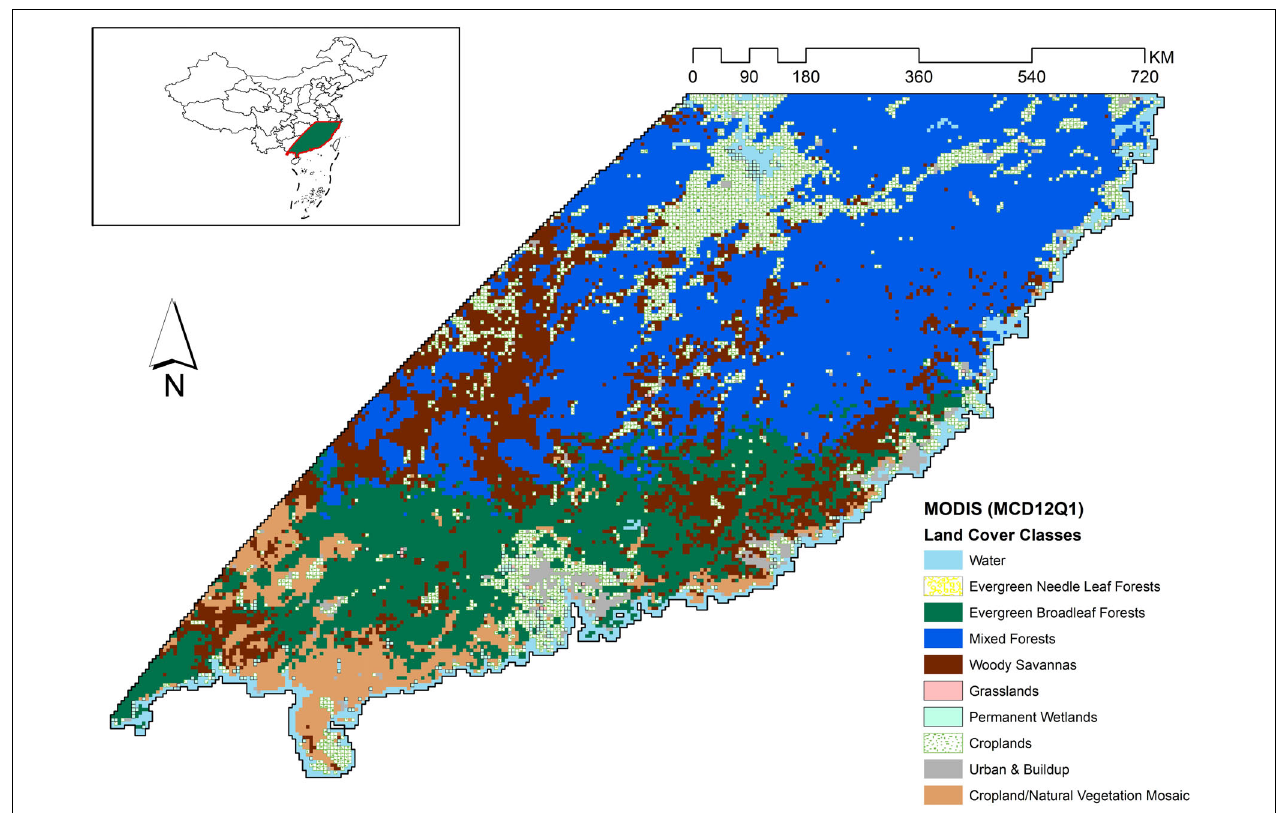
FIGURE 2 | Vegetation zones in study area as defined by the MODIS MCD12Q1 product. The region is predominantly covered with mixed forests, followed by evergreen broadleaf forests, and woody savannas when considering natural vegetation.